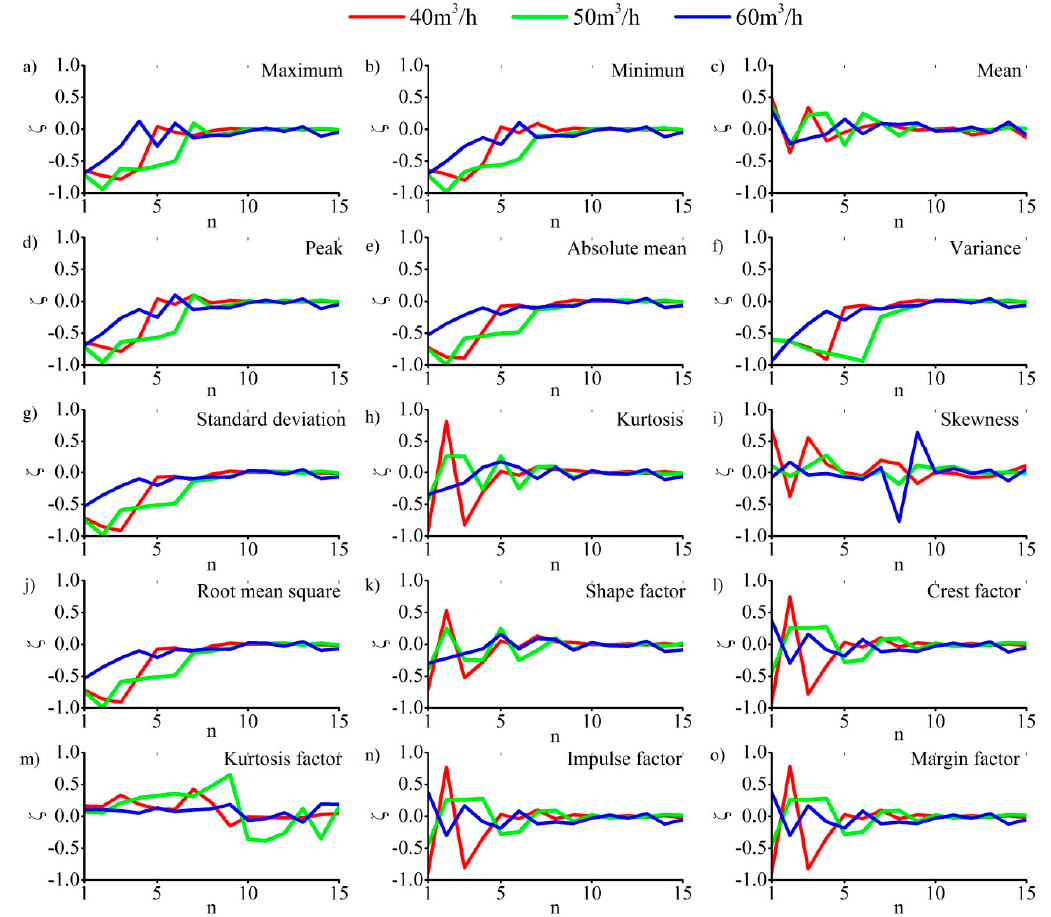
Figure 5. Grey slope correlation coefficient: ( a ) Maximum, ( b ) Minimum, ( c ) Mean, ( d ) Peak, ( e ) Absolute mean, ( f ) Variance, ( g ) Standard deviation, ( h ) Kurtosis, ( i ) Skewness, ( j ) Root mean square, ( k ) Shape factor, ( l ) Crest factor, ( m ) Kurtosis factor, ( n ) Impulse factor, ( o ) Margin factor